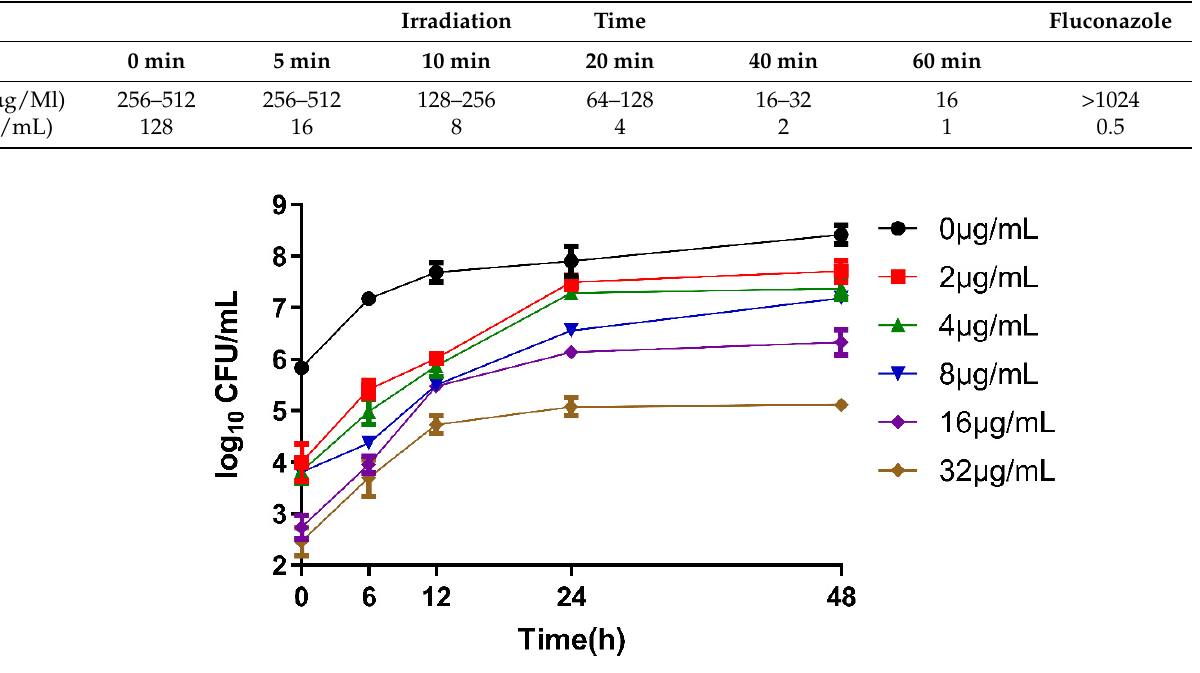
Table 2. The MICs and SMIC 80 s of EA, against Candida albicans and its biofilm.